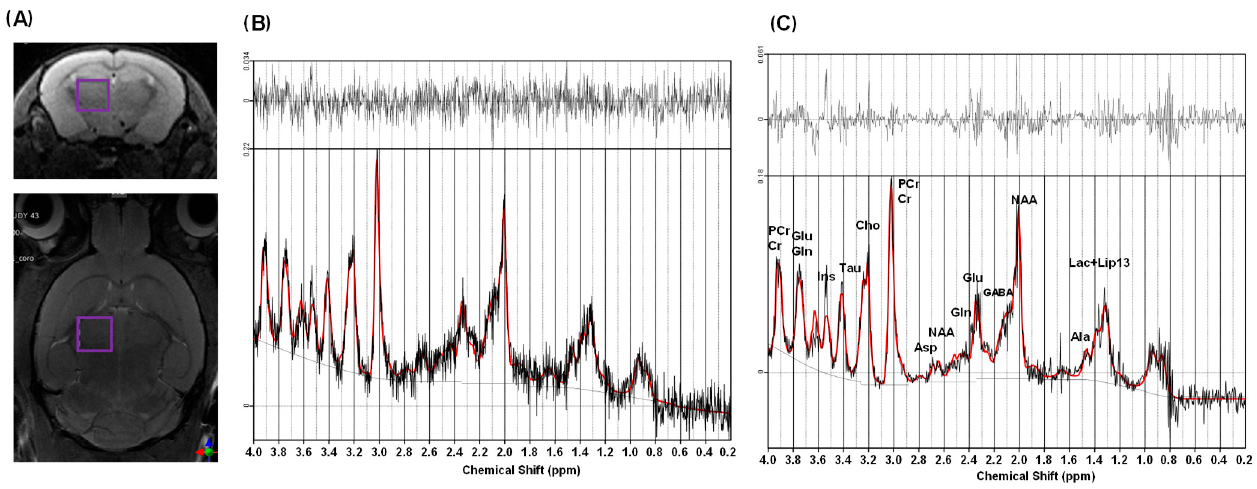
Figure 3. 1 H MRS data acquisition and analysis results. 1 H MRS voxel positioning on striatum (violet-colored box) ( A ), LCModel analysis without denoising ( B ), and LCModel analysis with denoising ( C ). Note: in ( B,C ), the red lines represent LCModel spectral fitting results, and the black lines are target in vivo 1 H spectra ( bottom ) and residual signals ( top ). Table 3. CRLB and concentration differences between raw and denoised 1 H MRS (normal) data.